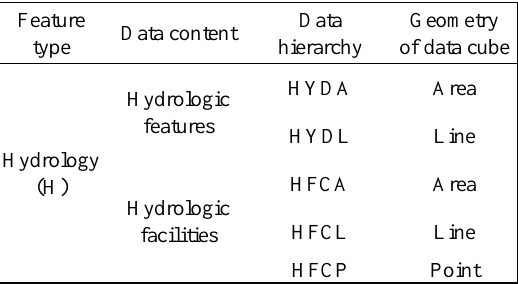
Table 1. Content of hydrologic